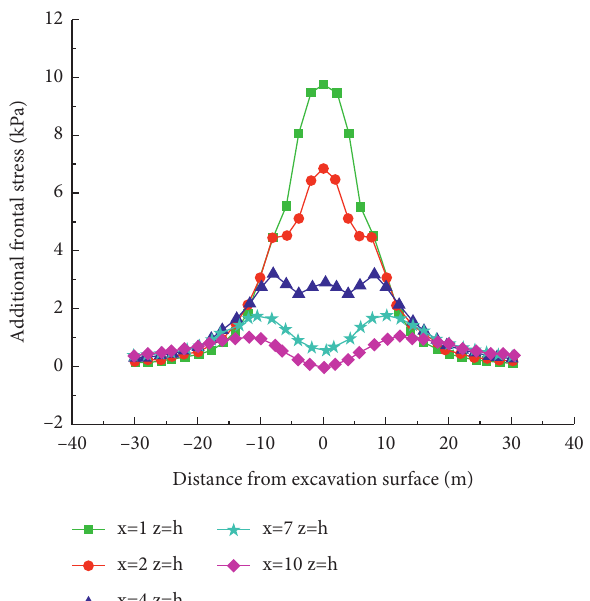
Figure 10: The distribution of the additional stress σ axis.